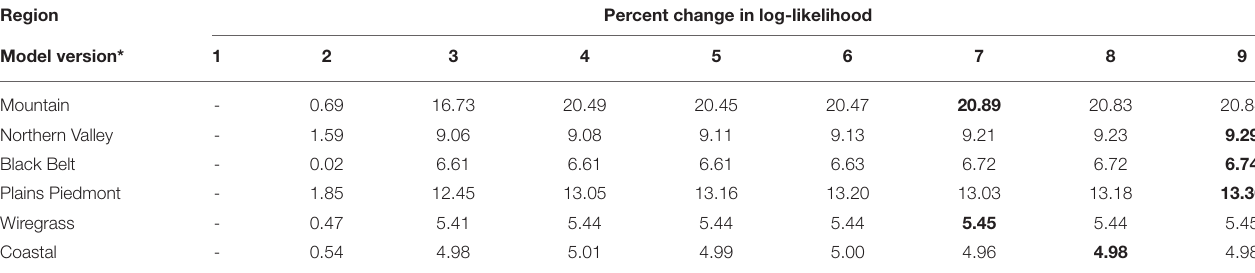
TABLE 5 | Percent change in log-likelihood estimates relative to the null model for each region.